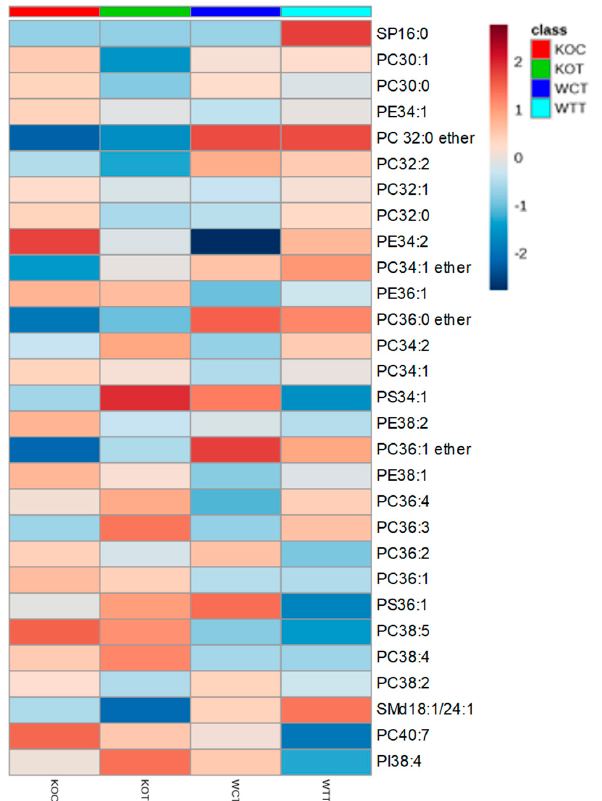
Figure 3. The relative intensity of the 30 most abundant lipids extracted from different groups of cells. Color represents the average intensity of group samples for each certain metabolite. Color scale of highest value was colored in dark green, the midpoint value colored in yellow and dark red for the lowest value. KOT: TSPO knockout cells with the treatment of oxLDL; KOC: TSPO knockout cells without the treatment of oxLDL; WTT: Wildtype cells with the treatment of oxLDL; WTC: Wildtype cells without the treatment of oxLDL.